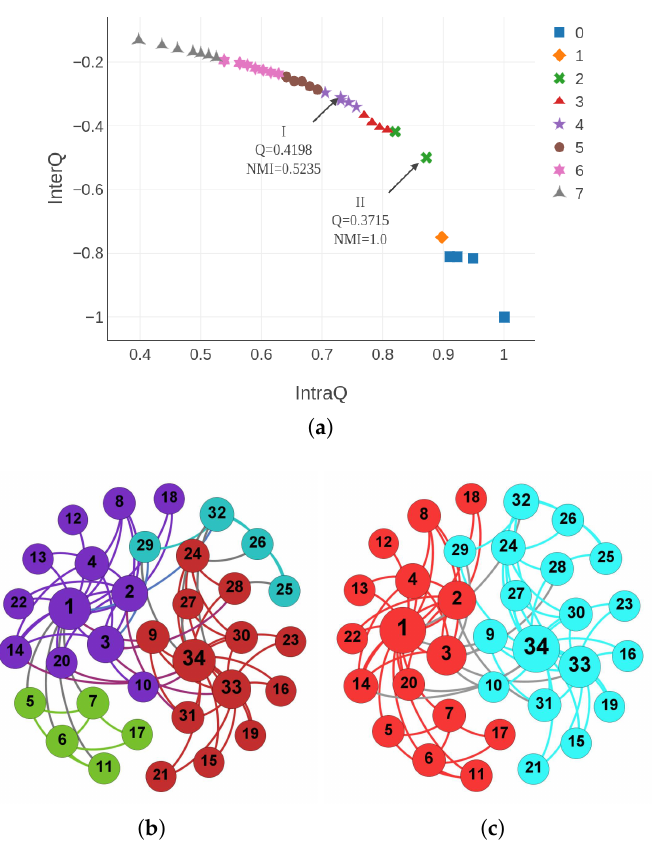
Figure 5. Results achieved by PCACD for the Karate network. ( a ) The non-dominated front fragments acquired, respectively, by eight islands of PCACD; ( b ) The community structure corresponding to solution ‘I’ with the highest Q score; ( c ) The community structure corresponding to solution ‘II’ with the highest normalized mutual information (NMI)